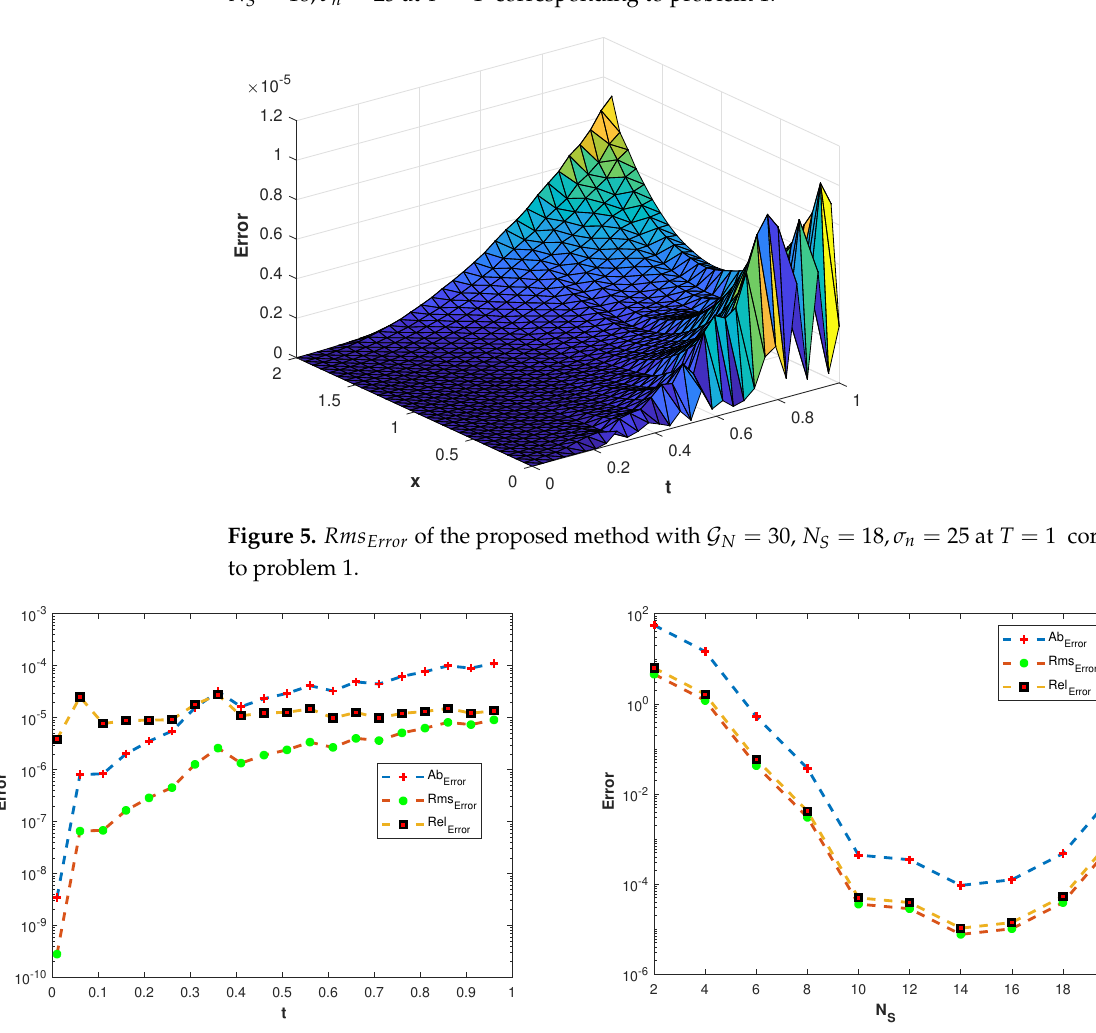
Figure 4: (a) Numerical solution of problem 1. (b) Ab Error of the proposed method with Figure 4. ( a ) Numerical solution of problem 1. ( b ) Ab Error of the proposed method with 18 , σ n = 25 at T = 1 corresponding to problem 1. N S = 18, σ n = 25 at T = 1 corresponding to problem 1.